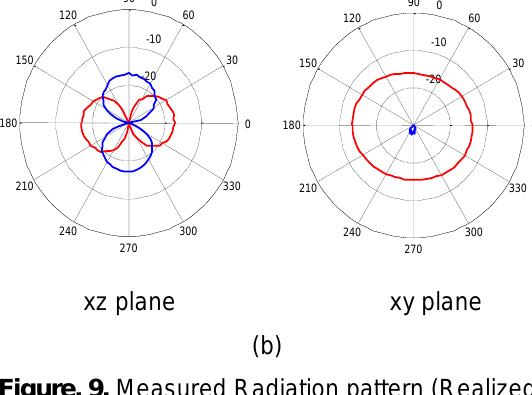
Figure. 9. Measured Radiation pattern (Realized Gain) of the antenna at (a) 790 MHz and (b) 510 MHz